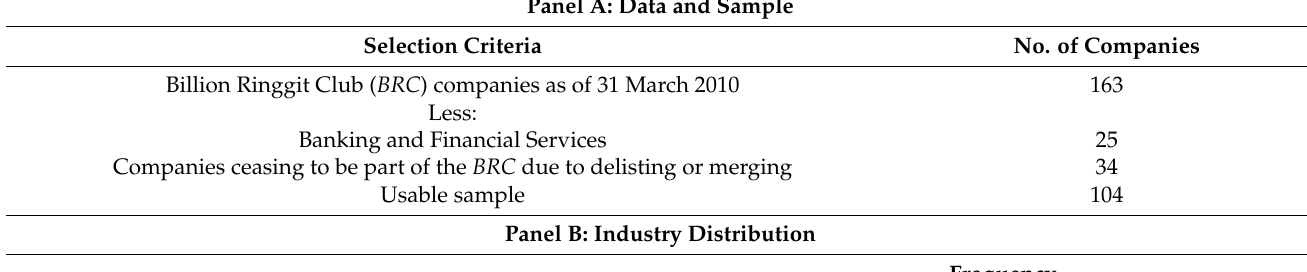
Table 1. Sample selection and distribution by industrial sectors. Panel A: Data and